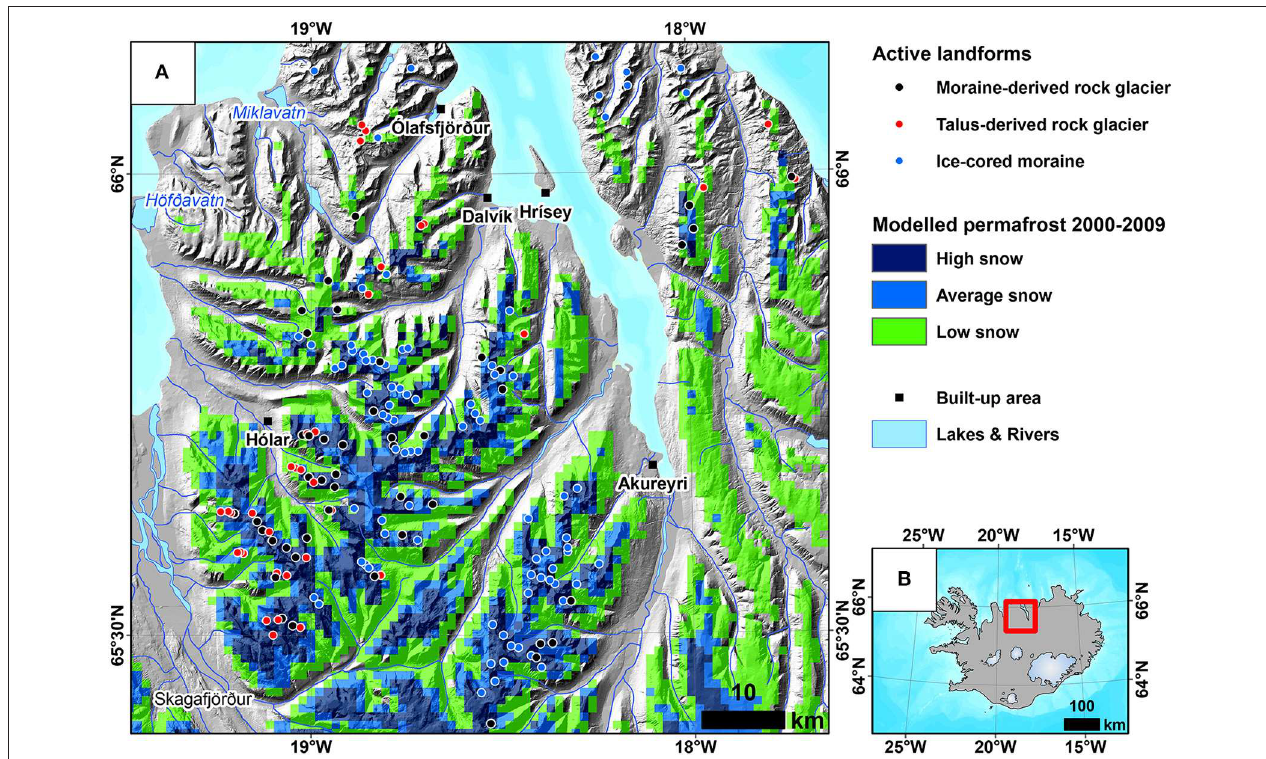
FIGURE 7 | (A) Outcome of the permafrost model simulations for the period 2000–2009 in comparison to the distribution of the active permafrost landforms, such as active moraine- and talus-derived rock glaciers, along with ice-cored moraines, as inventoried by Lilleøren et al. (2013). (B) Inset map. Modelled permafrost based on TTOP is shown (see Figure 9 for details). Map data from